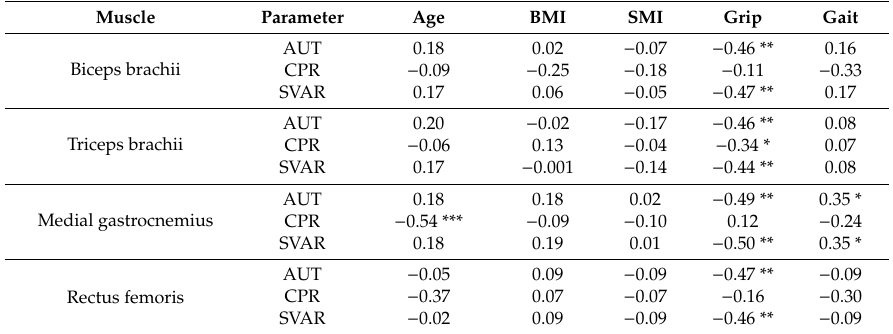
Table 4. Correlation coe ffi cients ( γ ) between muscle texture parameters and anthropometric variables.